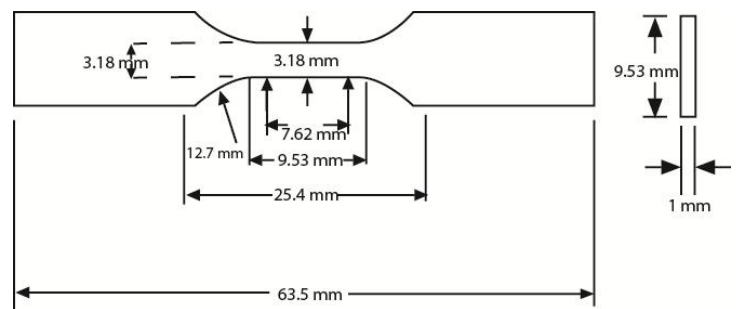
Figure 2. Type V: specimen dimensions.